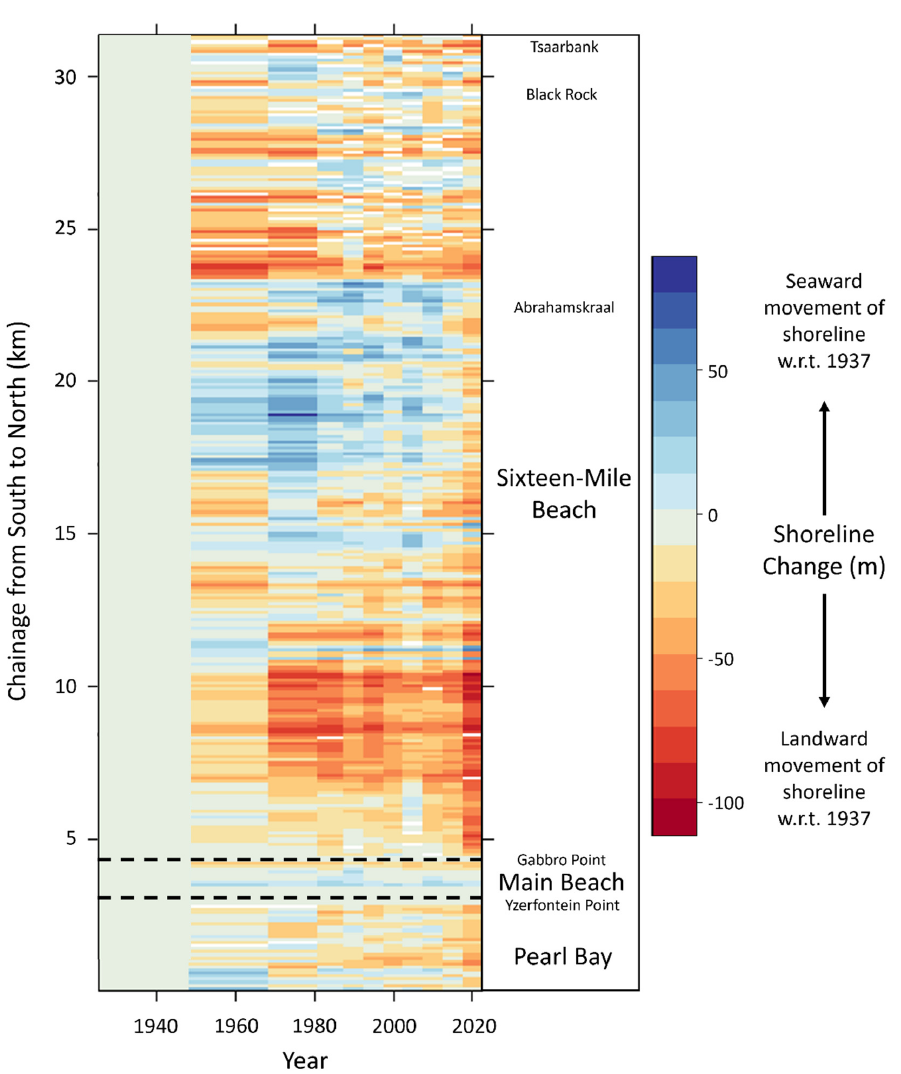
Figure 7. Time series heat-matrix represents the amount of change to the shoreline regarding the 1937 shoreline position over the eleven time periods. The shoreline has been under a constant state of change between each decade (see Figure 7). From 1937 to 1960, sections of shoreline moved between –20 m and +20 m away from their original positions, with slight accretion south of Black Rock and the middle of Sixteen Mile Beach, while the remaining sections of shoreline moved landward. Then, be- tween 1960 and 1977, more significant accretion occurred along the middle of Sixteen Mile Beach, while the southern end experienced increased erosion. Finally, less extreme changes occurred along the coastline between 1977 and 2015, considering the positional uncertainty values attached to these measurements. The most drastic changes shown in Figure 7 are those between 2015 and 2020, whereby most of the shoreline shows an increased landward movement. All of Pearl Bay,